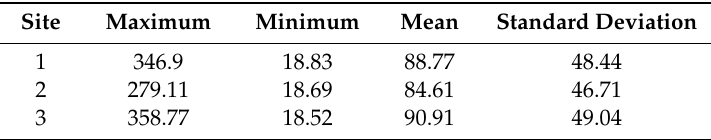
Figure 3. Time-varying characteristics of hourly particulate matter (PM 10 ) concentration: ( a ) the data measured at Site 1; ( b ) the data measured at Site 2; ( c ) the data measured at Site 3. The statistical characteristics of the PM 10 concentration data are shown in Table 1.